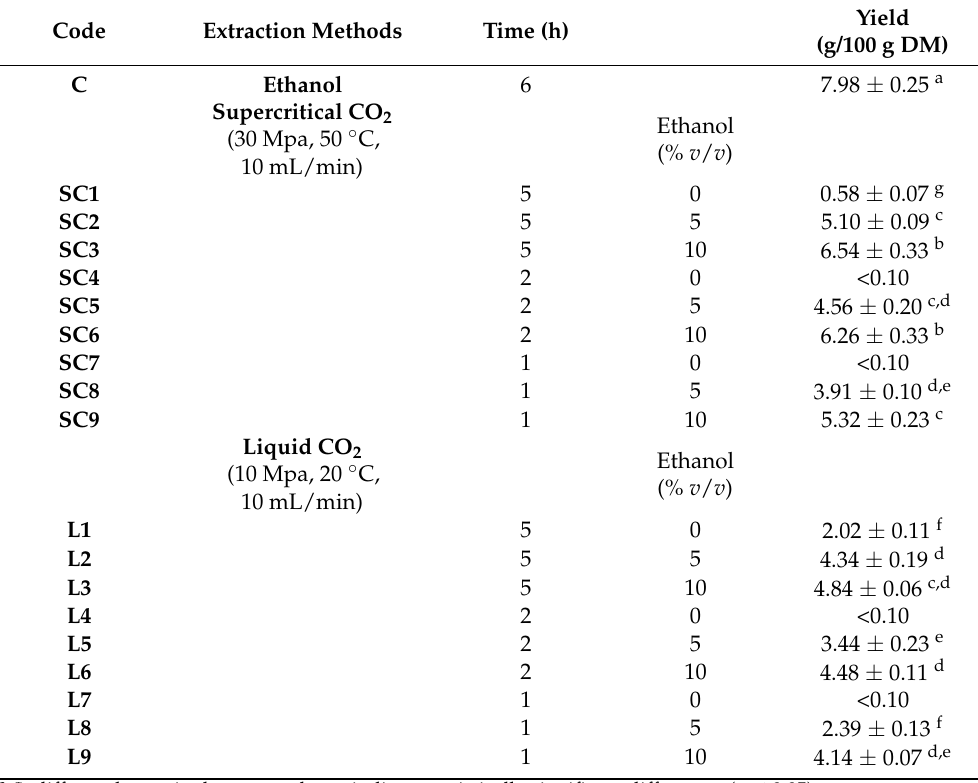
Table 1. Yield (g/100 g DM) of extracts obtained from basil by different